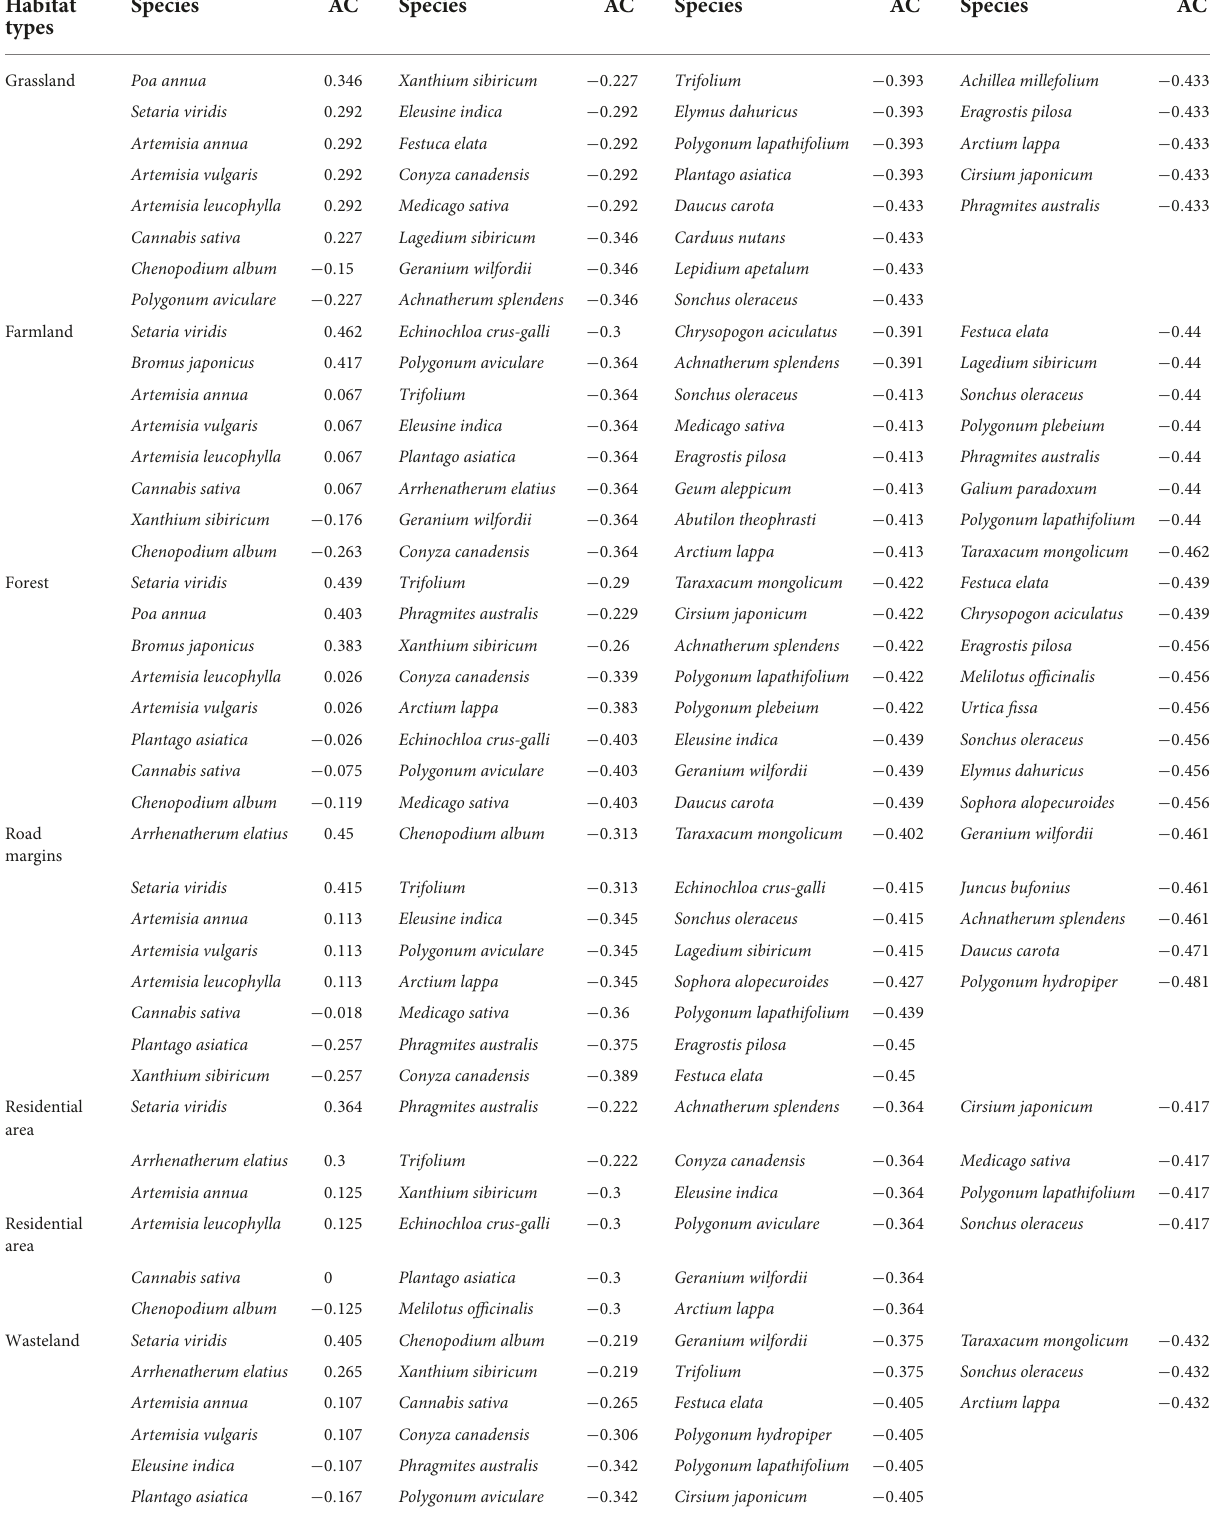
TABLE 2 Association coefficient (AC) between native species and Ambrosia artemisiifolia invasive habitat community in the Yili Valley. Habitat